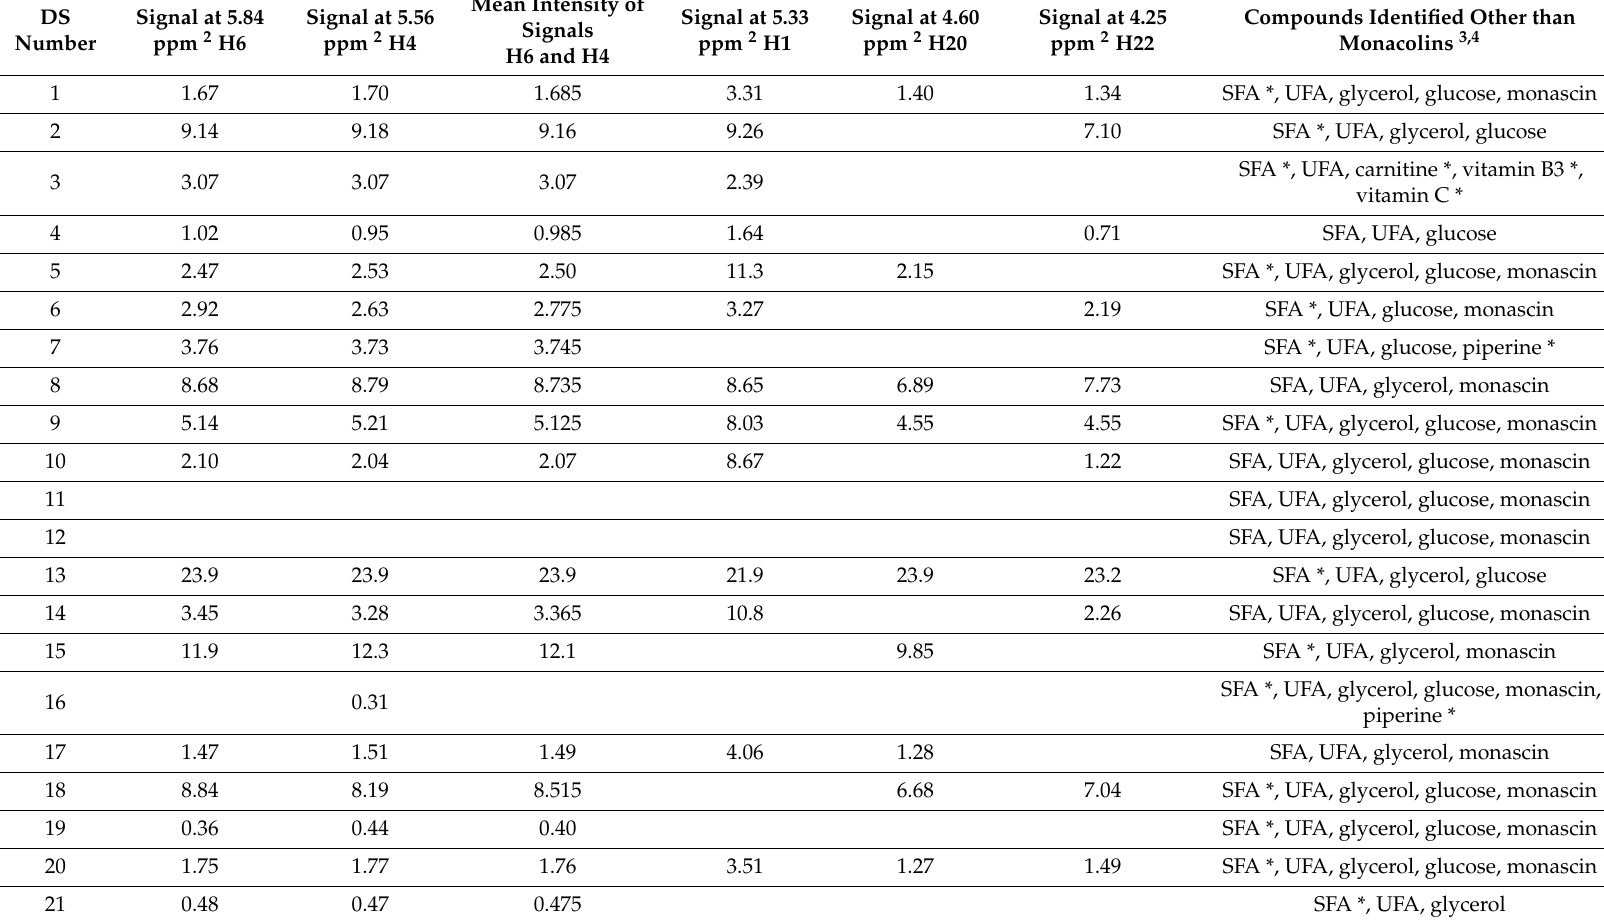
Table 3. 1 H-NMR analysis of RYR dietary supplements: quantitative determination of monacolins (mg per capsule or tablet) 1 and list of other compounds